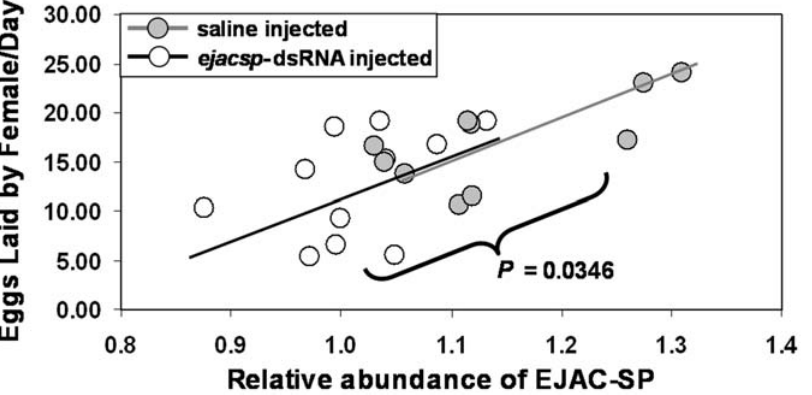
Figure 6. Phenotypic effects of ejac-sp knockdown. The abundance of EJAC-SP protein in a spermatophore (taken from a male just prior to being allowed to copulate successfully with a virgin female) predicts a male’s ability to induce a female to lay eggs. The difference between saline- and ejacsp -dsRNA injected males was also significant ( P =0.0346).